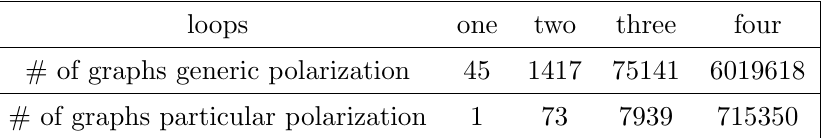
Table 2 . The (cid:12)nal number of diagrams which is obtained from canonical ribbon graphs by associat- ing vertices to internal and external positions. In the generic polarization all y ij are non-vanishing, while in the particular polarization any scalar product other than y 12 and y 34 is zero. The four-loop correlator in this paper was evaluated in the particular con(cid:12)guration, for which the number of graphs is greatly